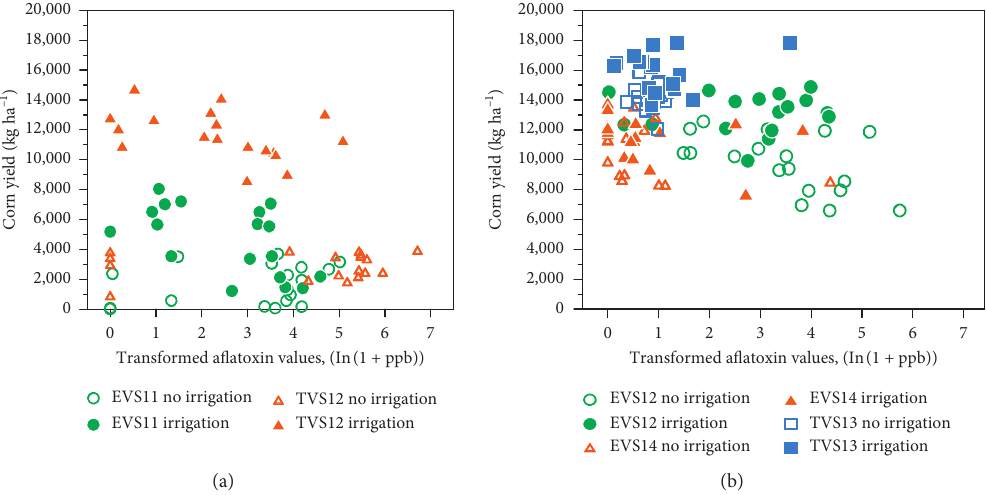
Figure 2: The relationship between corn yields and transformed aflatoxin values in the low (a) and moderate (b) moisture environments for five site-years during the 2011 to 2014 growing seasons across northern and central Alabama. Aflatoxin content (ppb) transformed as (ln(1+ppb)); threshold of 20 ppb � 3.04 on x -axis.